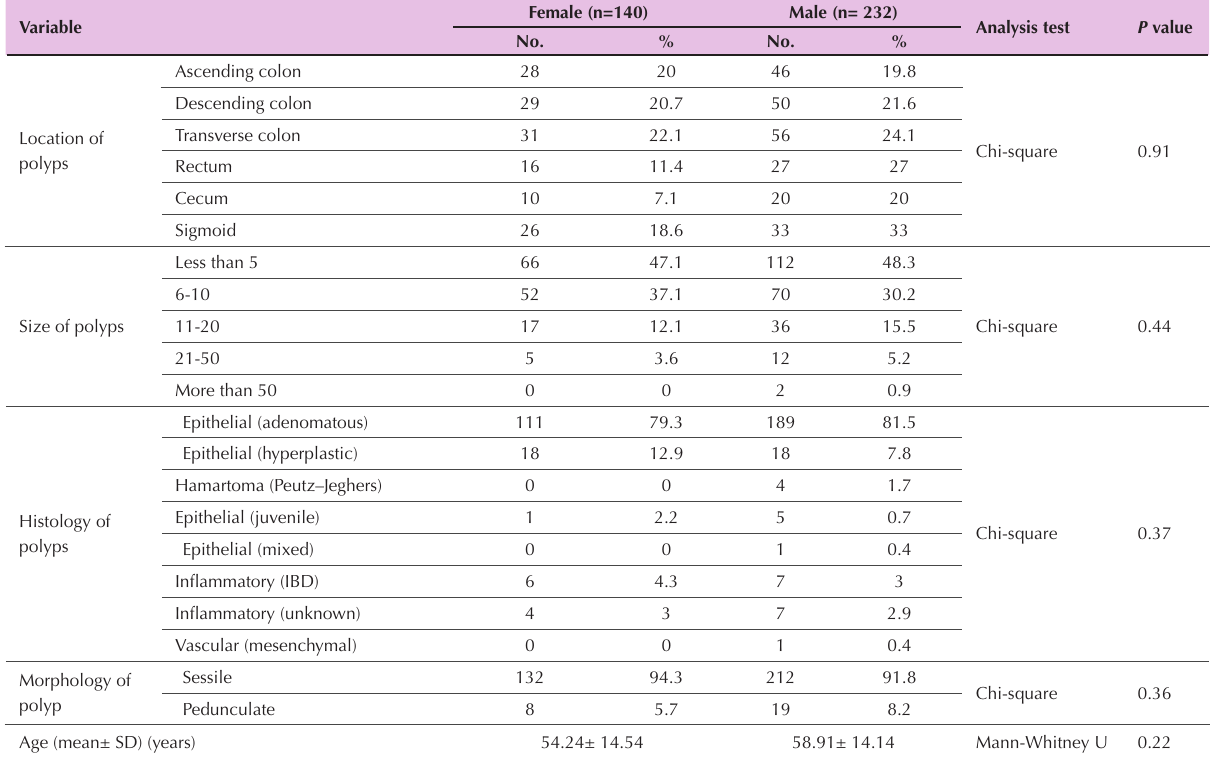
Table 1. Histologic and morphologic details of polyps based on gender Variable